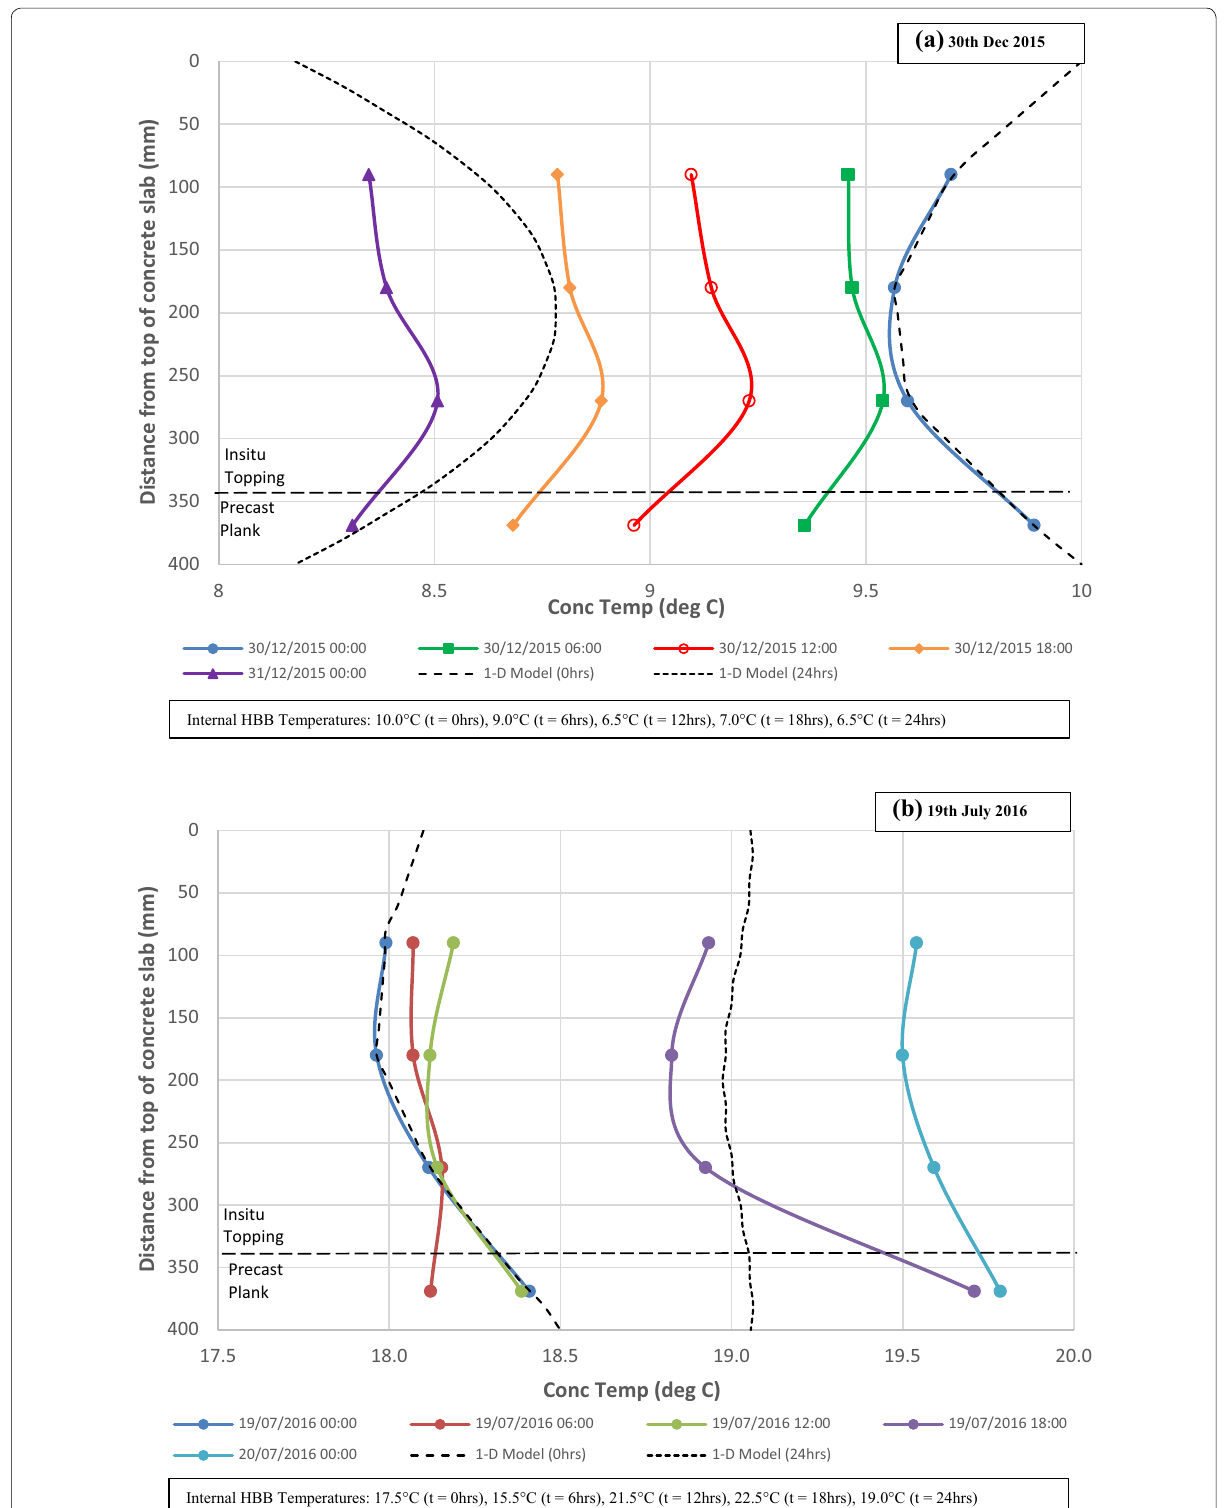
Fig. 11 Temperature profile in concrete slab for ( a ) negative temperature differential on 30 Dec 20 15, and ( b ) positive temperature differential on 19 July